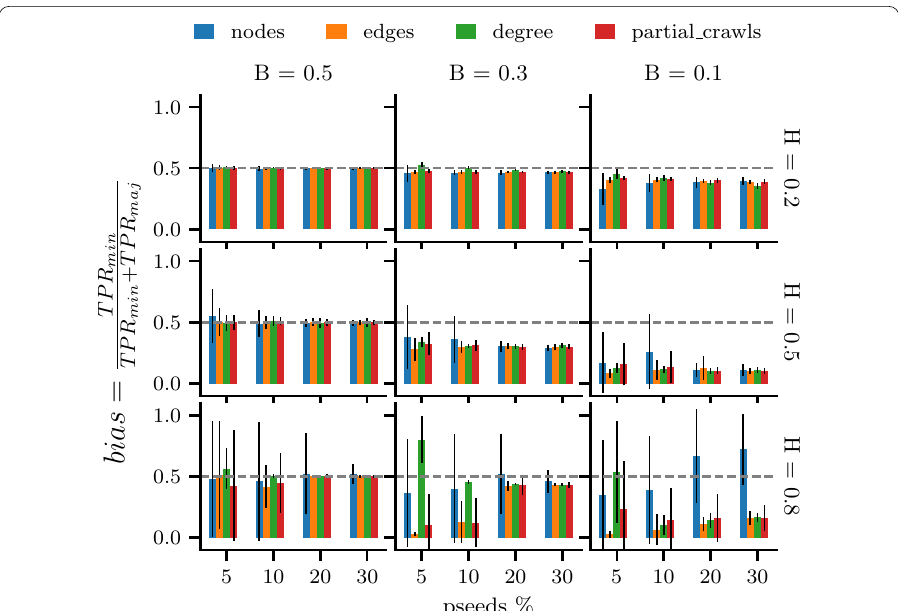
Fig. 5 RQ3: Direction of bias. We measure the direction of bias by comparing the true positive rates of each class. The unbiased case is bias = 0.5 , when both classes have the same true positive rates. Otherwise, results are biased towards majority nodes bias < 0.5 , or towards minority nodes bias > 0.5 . These are observations on small samples ( pseeds ≤ 30% ) where fluctuations are high, after this point bias scores converge or get better (i.e., towards bias = 0.5 ). We see that classification on heterophilic networks is less biased than